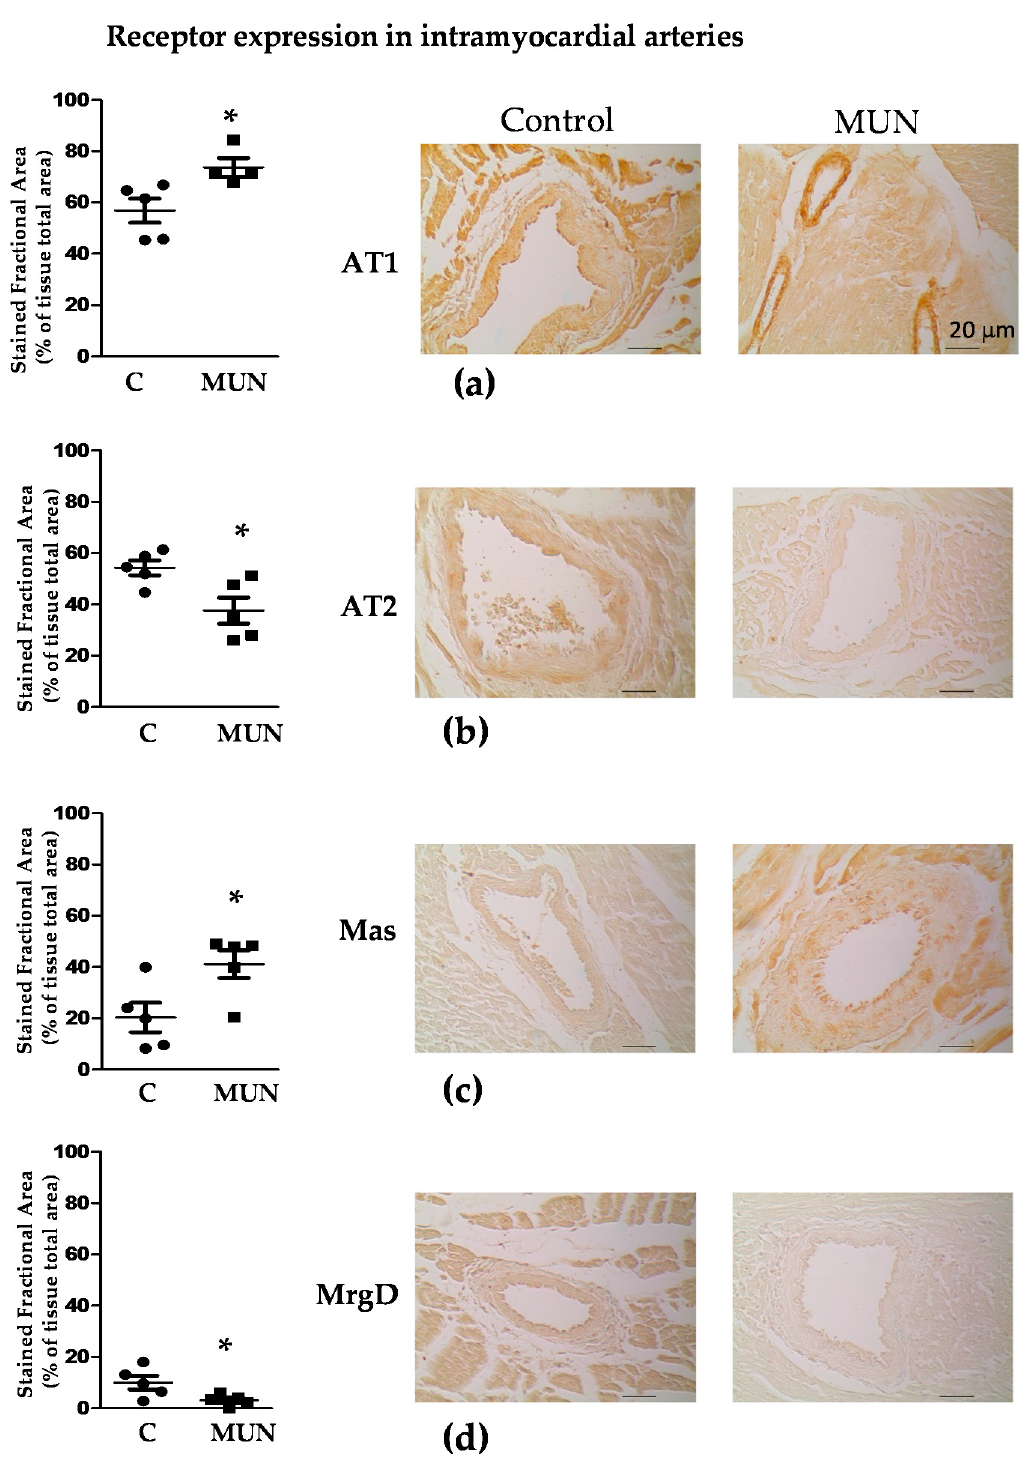
Figure 5. Immunohistochemistry for RAS receptors in intramyocardial arteries from 21-day old male offspring from rats exposed to maternal undernutrition during pregnancy (MUN) and control rats fed ad libitum (C). ( a ) AT1 receptors; ( b ) AT2 receptors; ( c ) Mas receptors; ( d ) MrgD receptors. Heart sections were stained with individual primary antibodies; the resulting immunocomplexes were detected with a biotinylated secondary antibody, and amplified by ABC complex, using 3,3 (cid:48) -diaminobenzidine (DAB) as chromogen. Images were obtained with a × 20 objective. Left panels show quantitative analysis of MUN and C intramyocardial artery-stained fractional areas (percentage of tissue total area) using SACAIA method. Representative DAB images are shown in right panels (scale bar = 20 µ m). Sample size per group: 7 rats from 5 litters. Student’s t test, * p < 0.05 compared to C